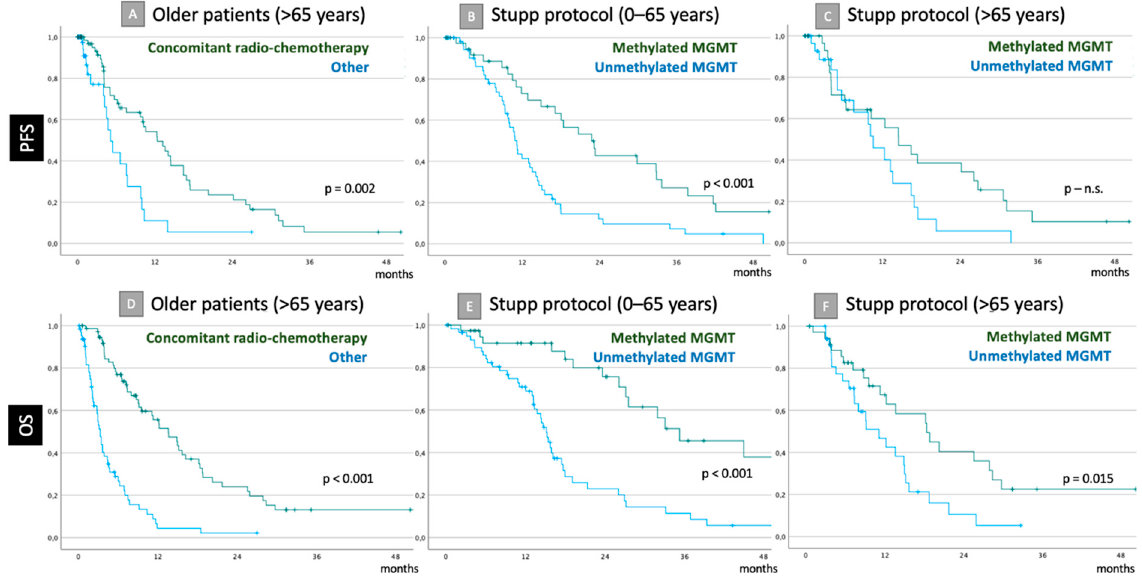
Figure 2. Kaplan–Meier graphs for PFS ( A – C ) and OS ( D – F ). For the older cohort (>65 years), if concomitant radio-chemotherapy was initiated or not ( A , D ). If concomitant radio-chemotherapy was applied, survival differences were presented in association with MGMT promotor status (MGMT) for younger ( B , E ) and older patients ( C , F ). Significance level is provided in conformity to LogRank tests. Statistically significant differences were revealed for all pairs except for concomitant radio-chemotherapy efficacy in relation to MGMT promotor status in older cohort ( C ).